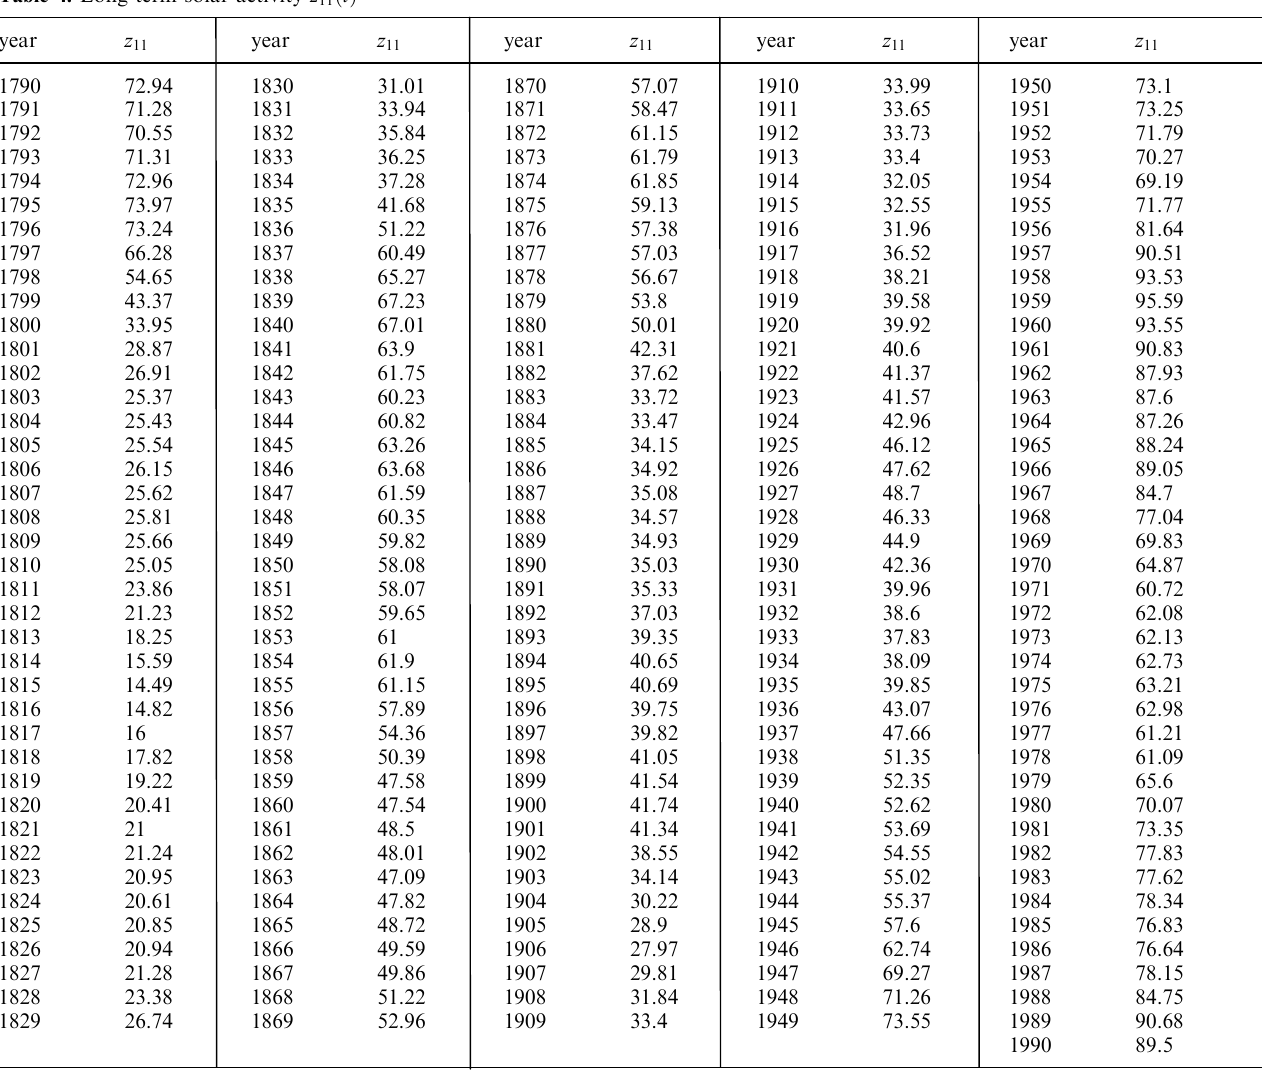
Table 4. Long-term solar activity z 11 (cid:133) t (cid:134)